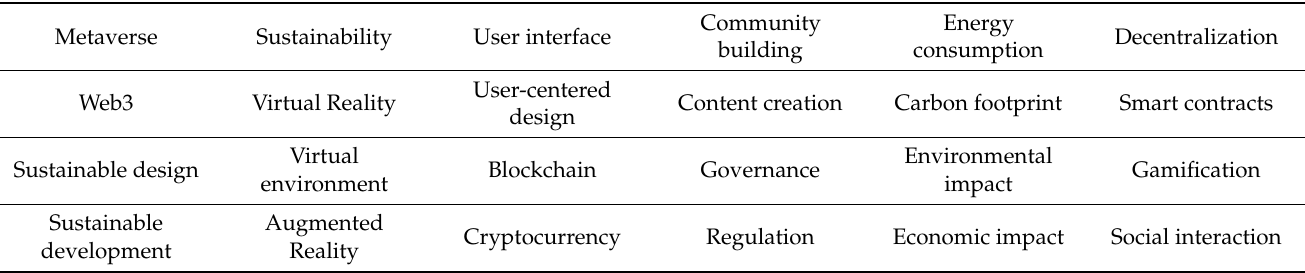
Table 1. Keywords Used in Search